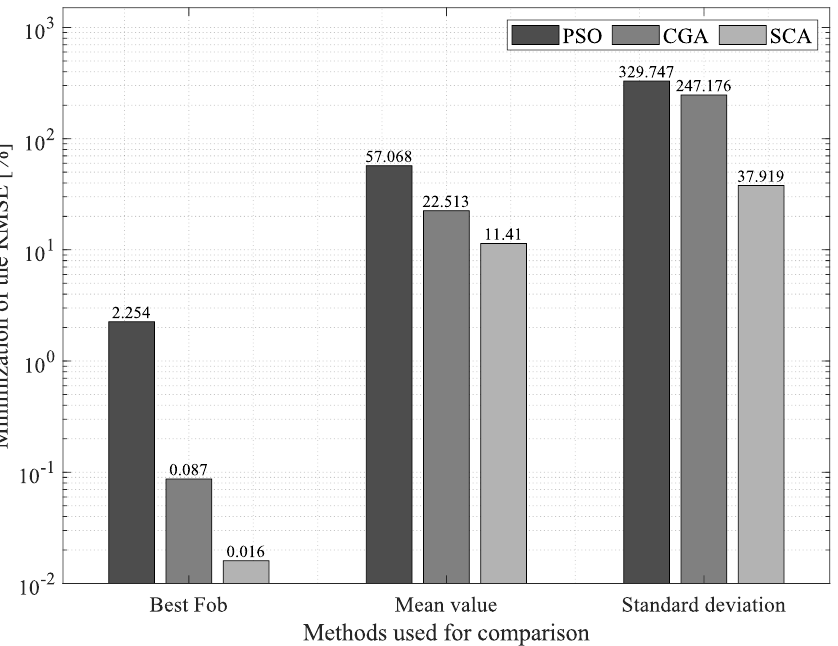
Figure 7. Minimization of the RMSE in the TDM of a MSX 60 PV panel under a 1000 W/m 2 irradiance level obtained by the SSA compared to the other